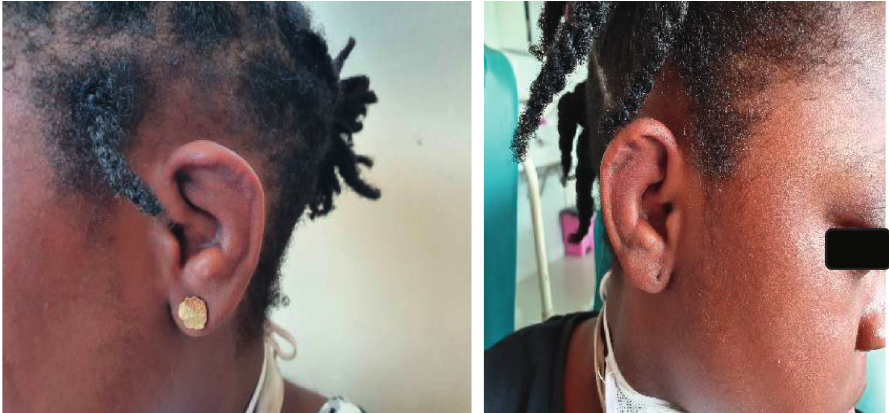
Figure 1: Swollen erythematous right and left ears with shriveled up outer ears resembling cauliflower ears.